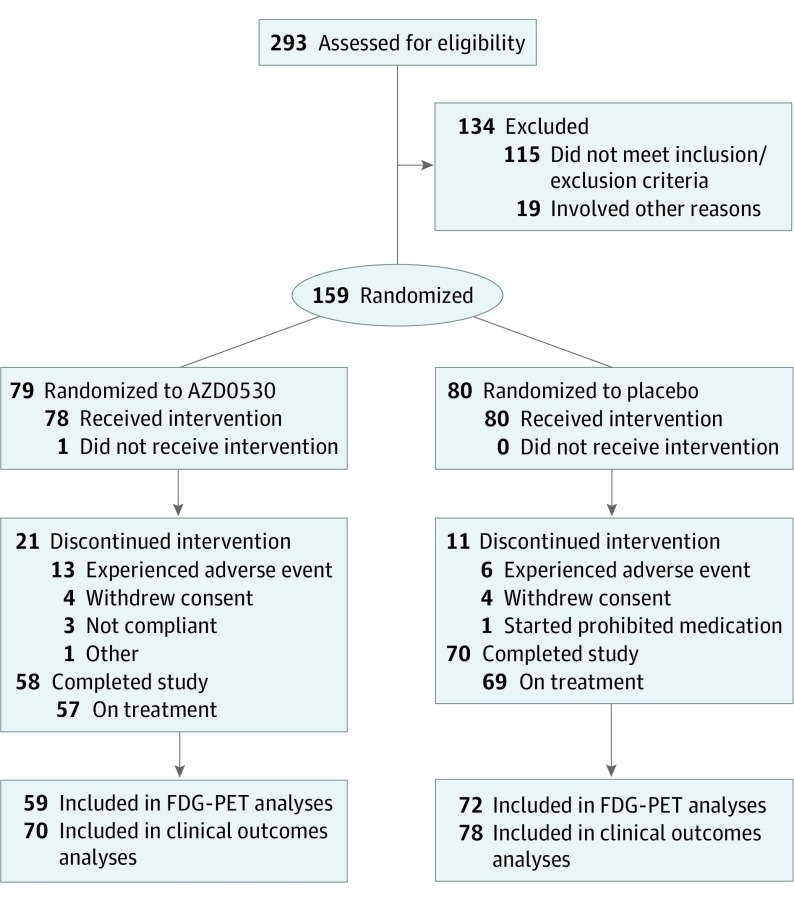
CONSORT Diagram